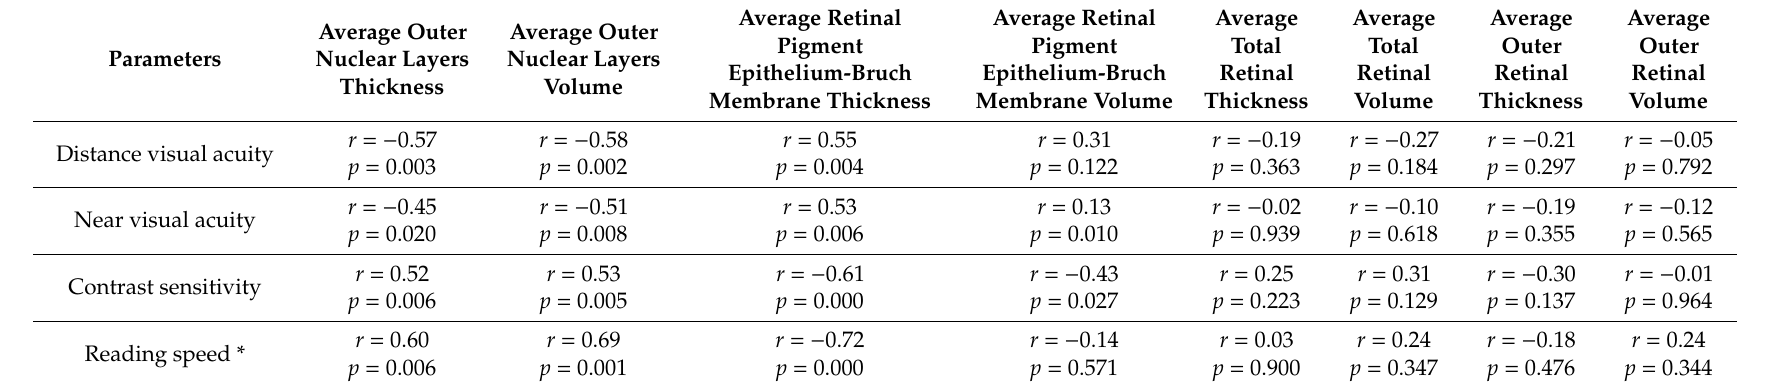
Table 4. Correlation between visual parameters and quantitative OCT